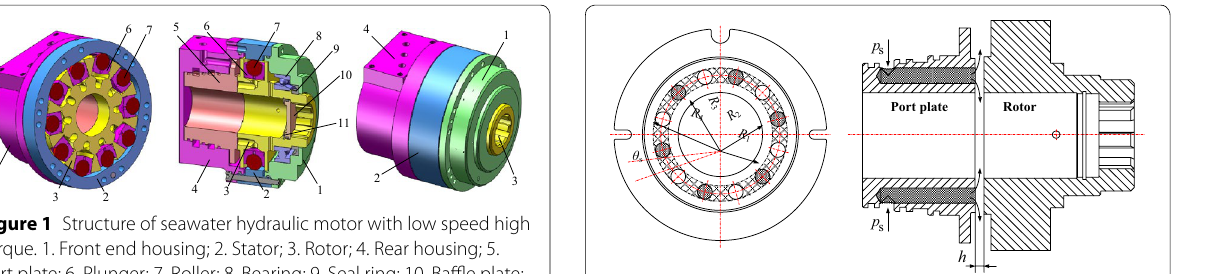
Figure 2 Structure and distribution of port plate in seawater hydraulic